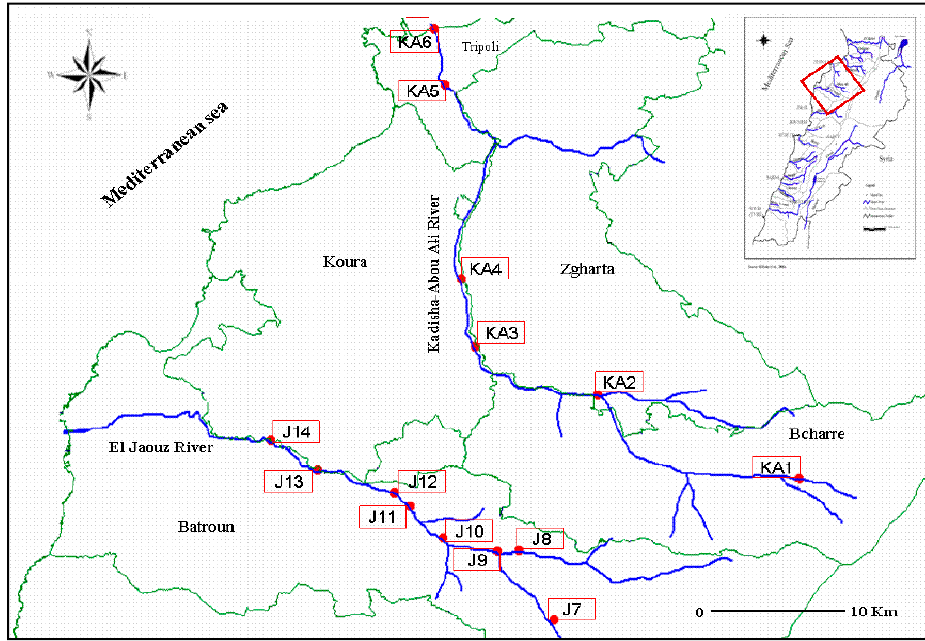
Figure 1. Map of the Kadisha-Abou Ali and El Jaouz rivers. Red dots refer to the monitoring sites (KA1 to KA6 for Kadisha-Abou Ali River and J7 to J14 for El Jaouz River).